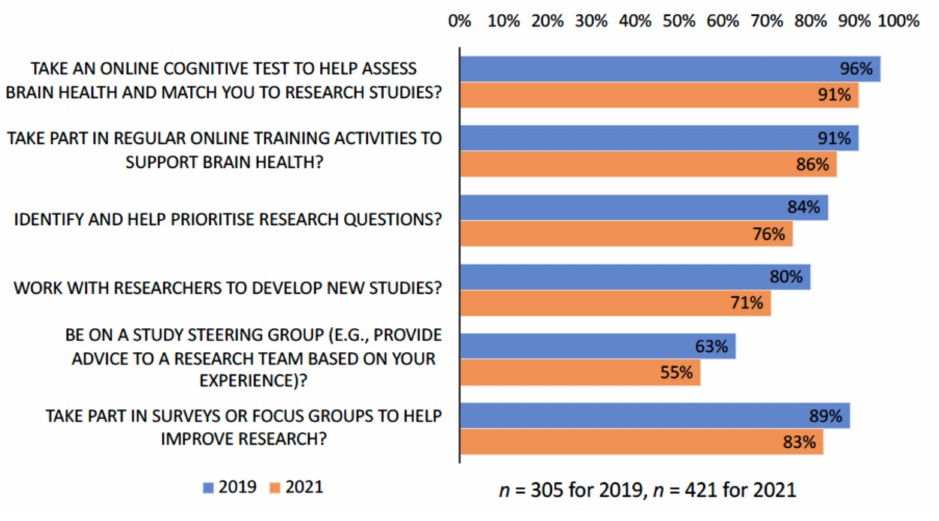
Figure 5. Involvement in